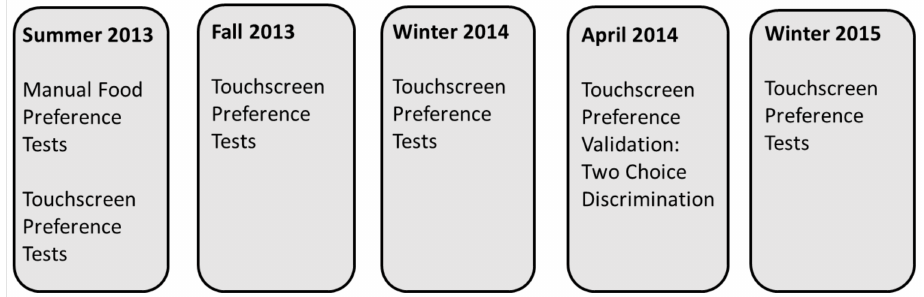
Figure 1. Flowchart of the experimental